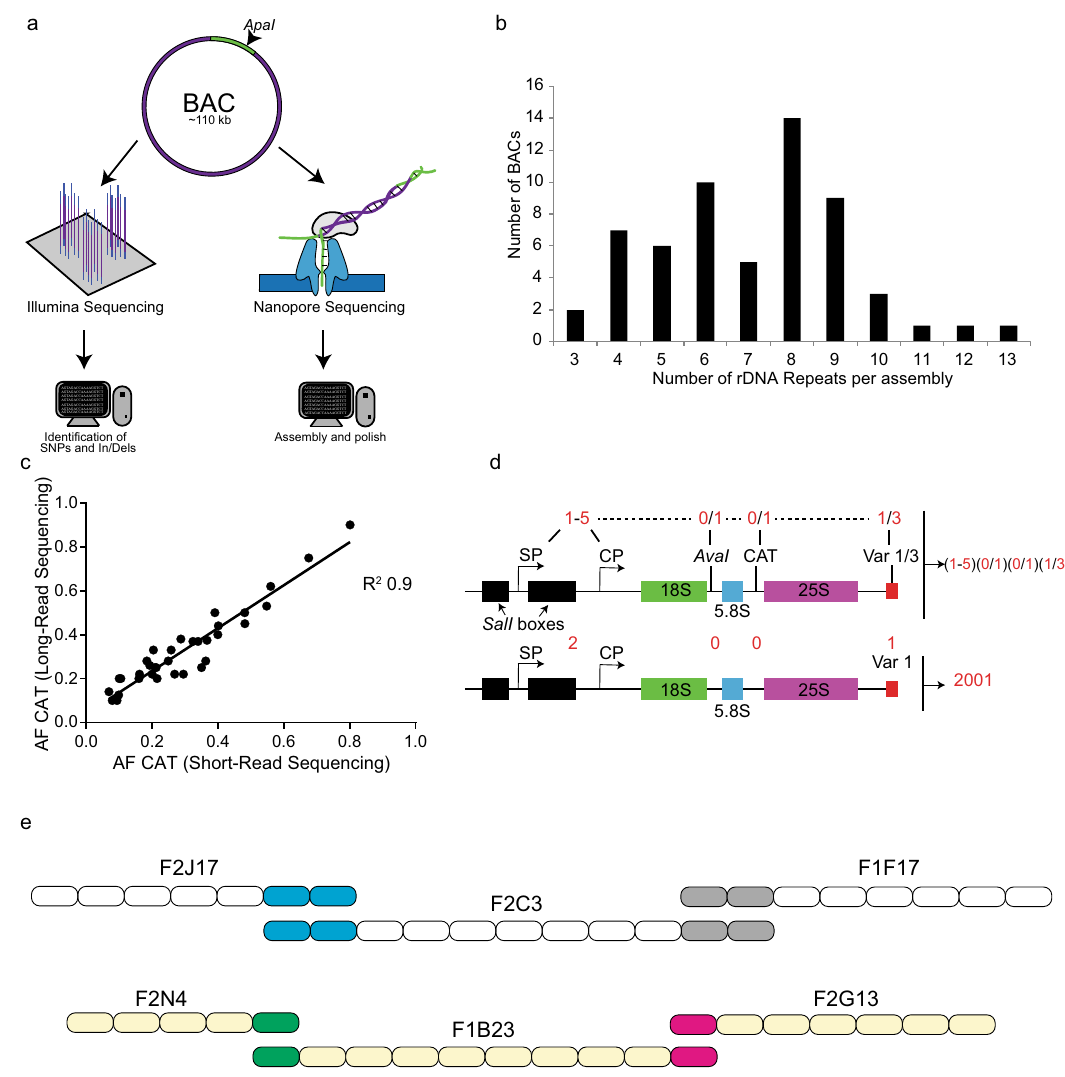
Fig. 1 Sequencing and polishing BACs containing rDNA contigs. a Scheme depicting the sequencing and assembly strategy combining long-read (NanoPore) and short-read sequencing (Illumina) of BACs containing rDNA genes. b Graph depicting the number of rDNA units per assembled BAC. c Correlation analysis of the CAT allele frequencies derived from the long- and short-read sequencing approaches. Each dot represents an individual assembly. d Graphical description of the numeric codes attributed to the described rDNA unit features. Each four-digit code corresponds to a unique rDNA variant. An example is shown of an rDNA variant that carries 2 promoters (1 spacer promoter, SP and 1 core promoter, CP), no AvaI site (0), no CAT insertion (0), and the 3 ′ -ETS VAR1. It is de fi ned as a “ 2001 ” rDNA repeat. e Schematic representation of the overlap between BACs F2J17-F2C3-F1F7 and F2N4-F1B23-F2G13. Each rDNA units is de fi ned by a rectangle with the four feature barcode and the SalI box barcode in